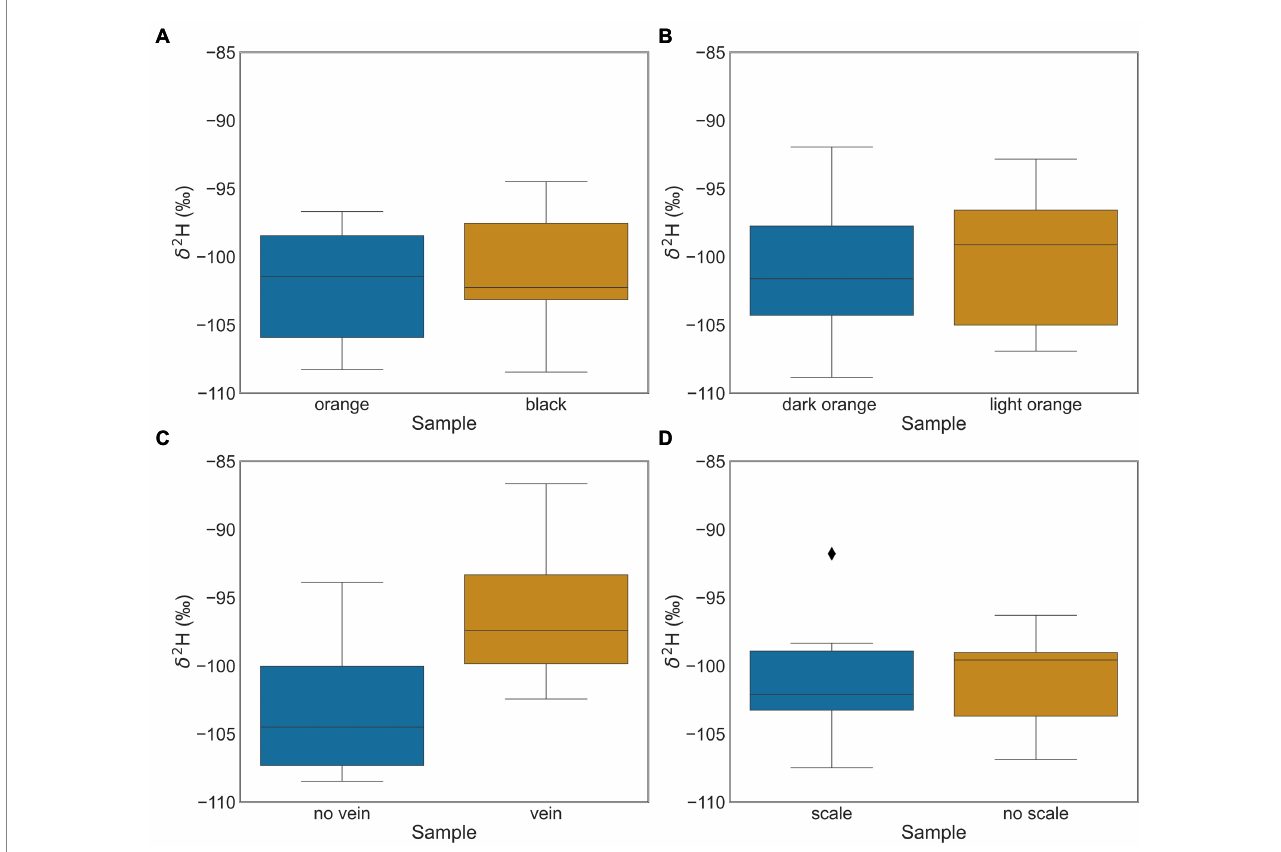
FIGURE 5 Box and whisker plots of intra-wing differences in δ 2 H (‰), comparing the standard wing samples (from location S) to (A) wing pigmentation (orange vs. black), n = 12; (B) wing shade (dark orange vs. light orange), n = 13; ( C* ) vein or no vein wing samples, n = 13; and (D) scaled or non-scaled wing samples, n = 12. There is a mean difference of ~9‰ between samples containing veins and samples with no veins. Panel C* has an asterix to indicate statistical significance between the compared intra-wing differences in δ 2 H (‰; i.e., vein or no vein wing samples). Black diamond points indicate